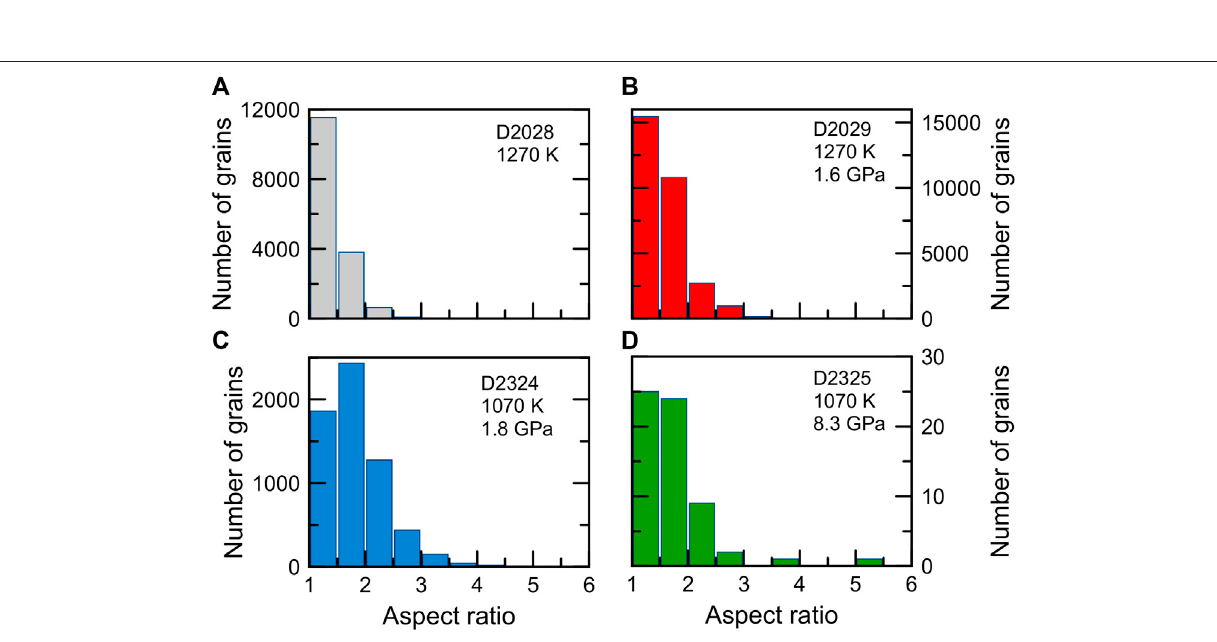
Frontiers in Earth Science |